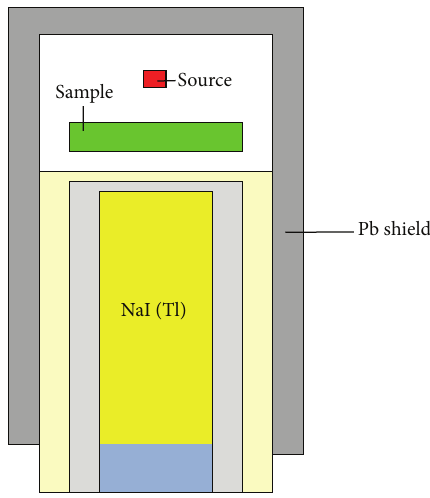
Figure 4: Schematic representation of simulation and locations of modeled